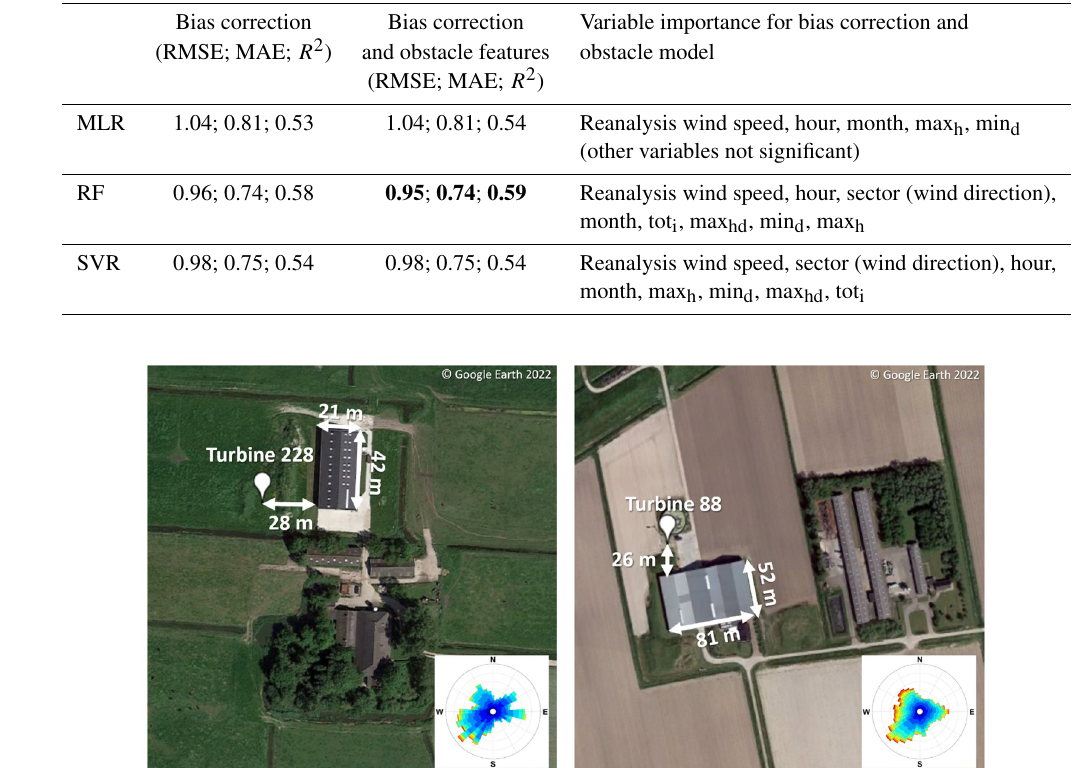
Figure 8. Example validation sites (228 and 88) showing a typical turbine location as well as the location of obstacles relative to the